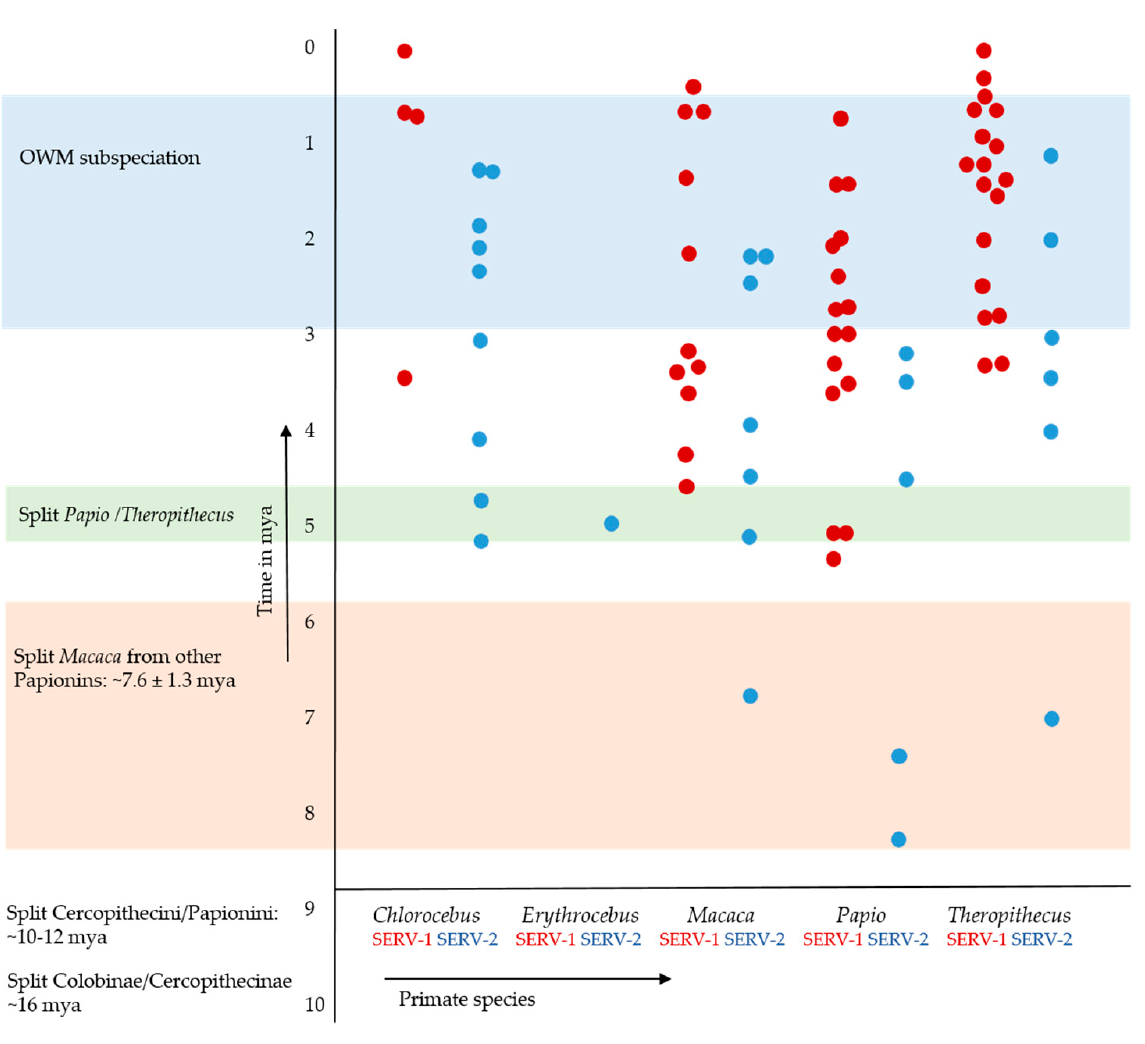
Figure 3. Estimated integration times of full-length, homozygous Cer-SERV proviruses in OWM genomes calculated using the “fast” mutation rate of 5 × 10 − 9 s/s/y, which appears to be the most appropriate for the dataset [43]. Using a slower rate would make the proviruses more than twice as old, with many predating accepted OWM speciation times. Estimated evolutionary events in OWM are indicated on the Y-axis (for reference, see [4]). Cer-SERV-1 is shown in red, Cer-SERV-2 in blue.